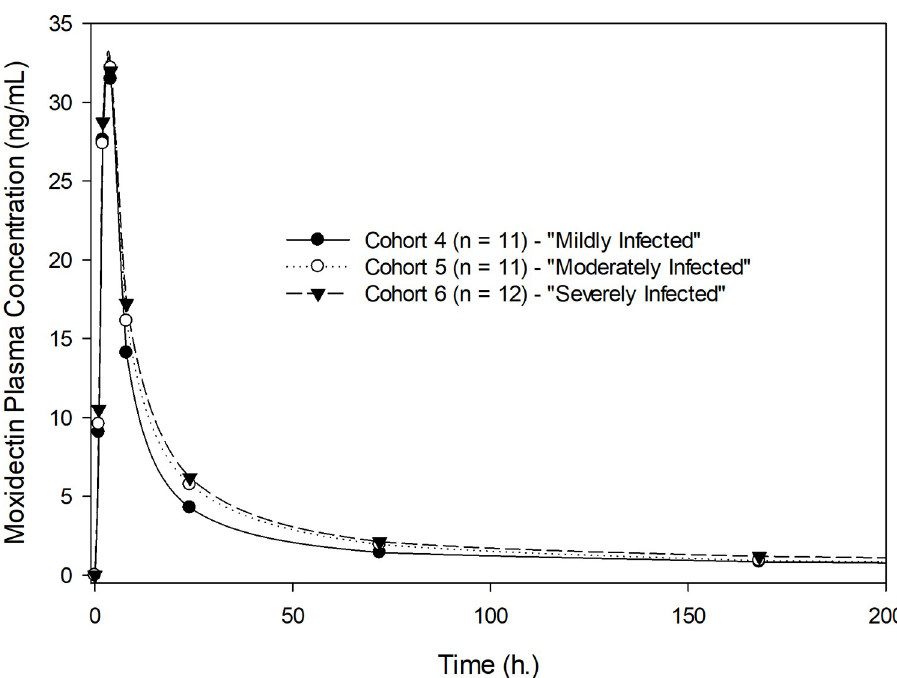
Fig 3. Plasma concentrations of moxidectin after single oral administration of 4 mg by severity of infection, displayed as geometric means.